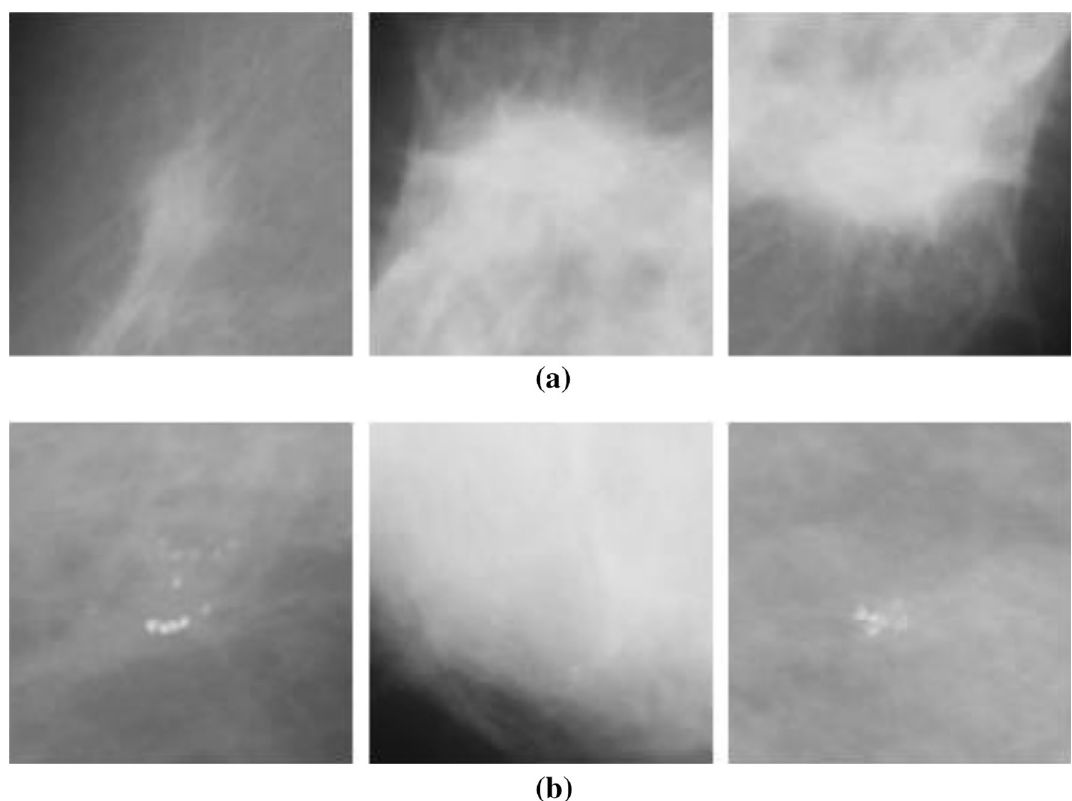
Figure 5. ( a ) Samples with different orientations of calcification abnormalities from the combined datasets from DDSM + CBIS and MIAS databases. ( b ) Samples with different orientations of mass abnormalities from the combined datasets from DDSM + CBIS and MIAS